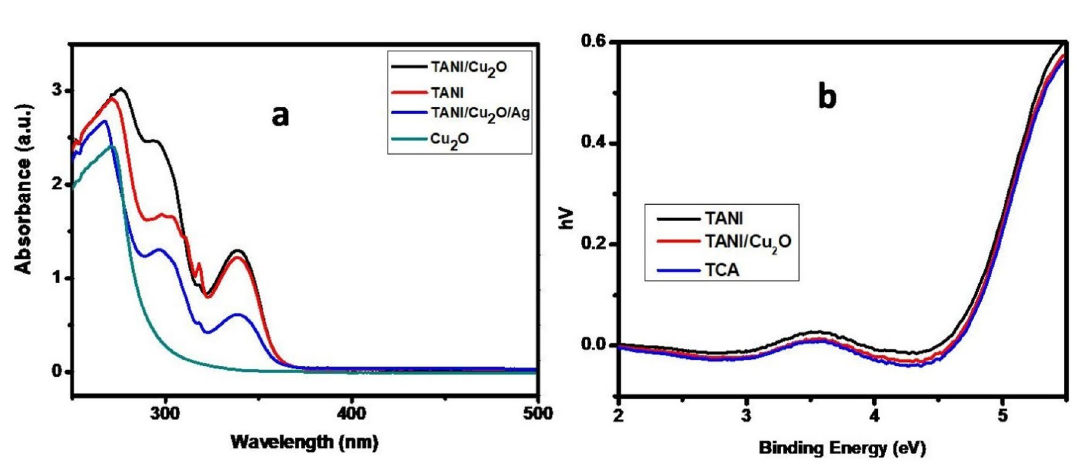
Figure 7. UV–Visible ( a ) absorption and ( b ) DRS spectra of prepared